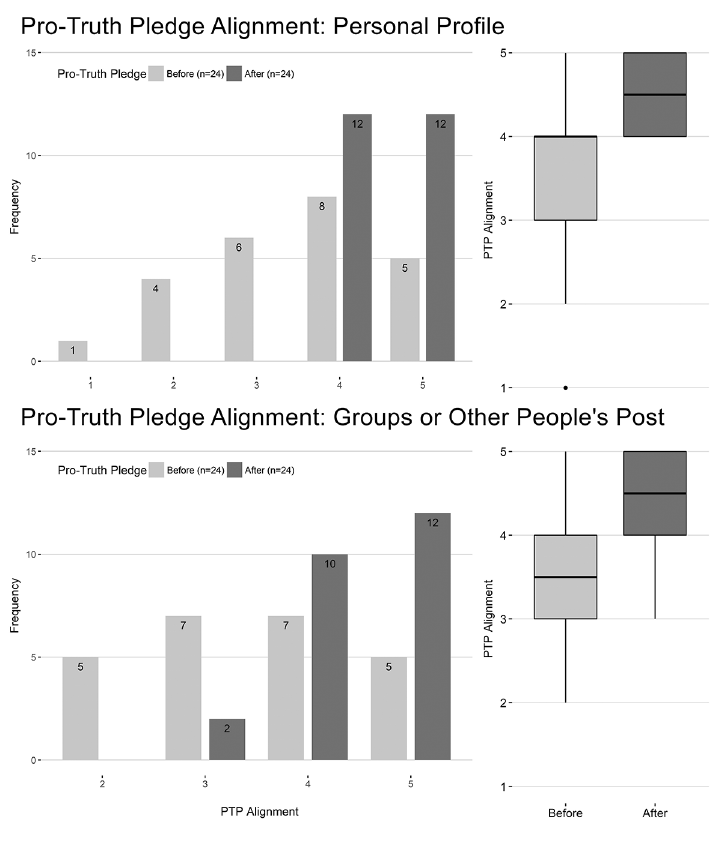
Figure 1. Visual summary of preliminary survey data with PTP alignment in Facebook